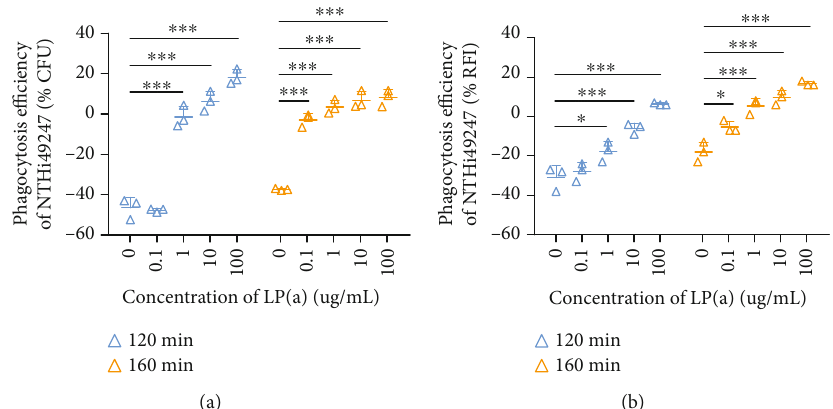
Figure 6: Lp(a) enhanced phagocytic e ffi ciency of U937 macrophages in a dose-dependent manner. Lp(a) at 10-fold increasing doses, from 0.1 μ g/mL to 100 μ g/mL, was used in the phagocytosis assay, and its e ff ect was evaluated by CFU counts (a) and RFI values (b). The MOI of NTHi49247 was 63:1. Values represent means ± SD from three independent experiments. Statistical signi fi cance of the di ff erences between groups was determined by two-way ANOVA and the Bonferroni post hoc test. ∗ P < 0 : 05 , ∗∗∗ P < 0 : 001